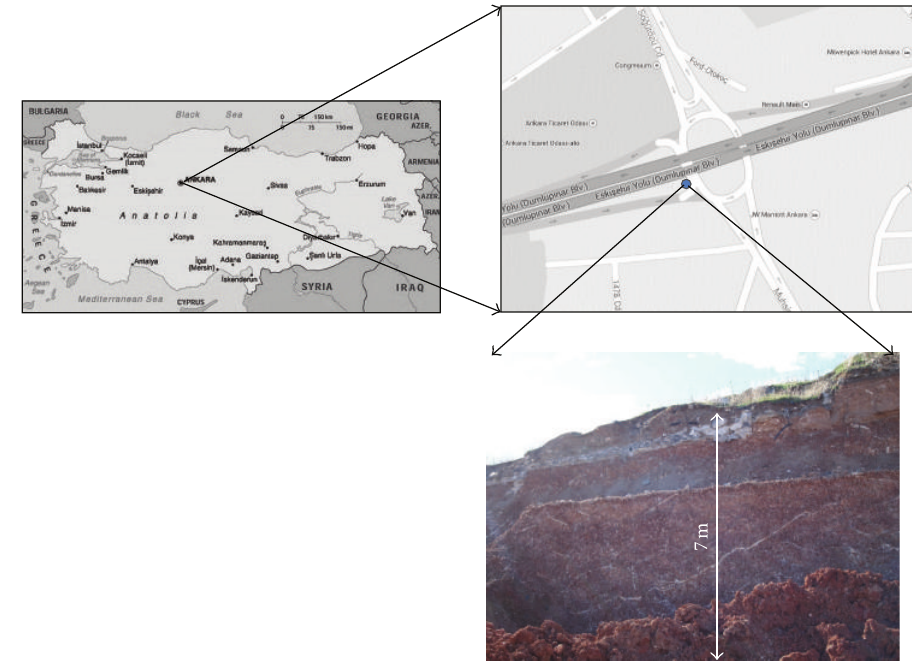
Figure 1: The soil sampling